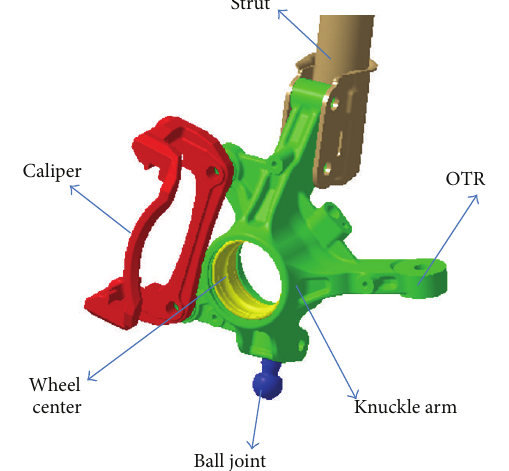
Figure 2: FE model of knuckle.